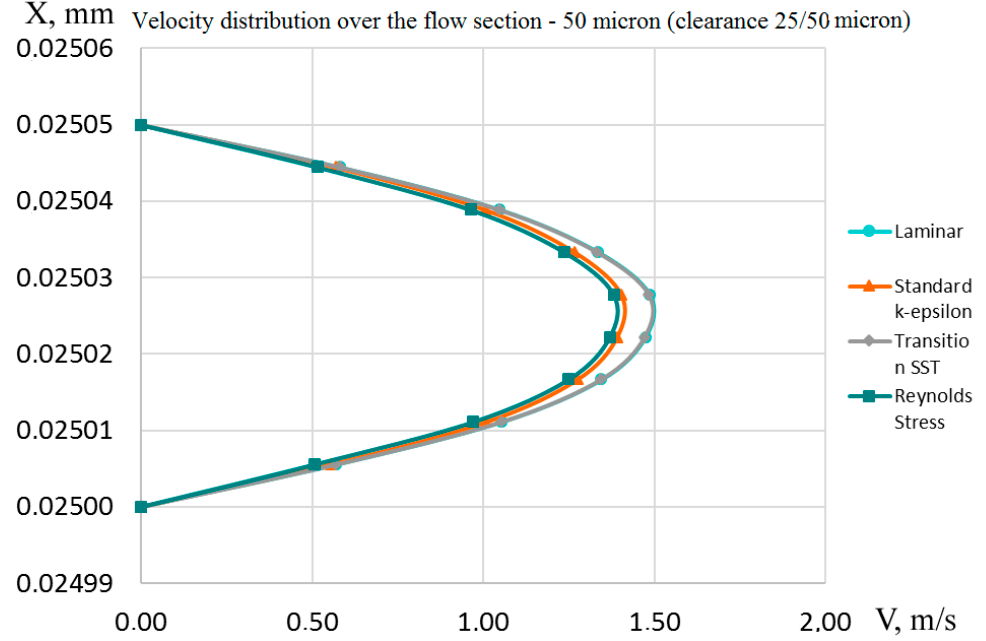
Figure 8. Velocity distribution over the flow section (laminar and transition SST curves match).